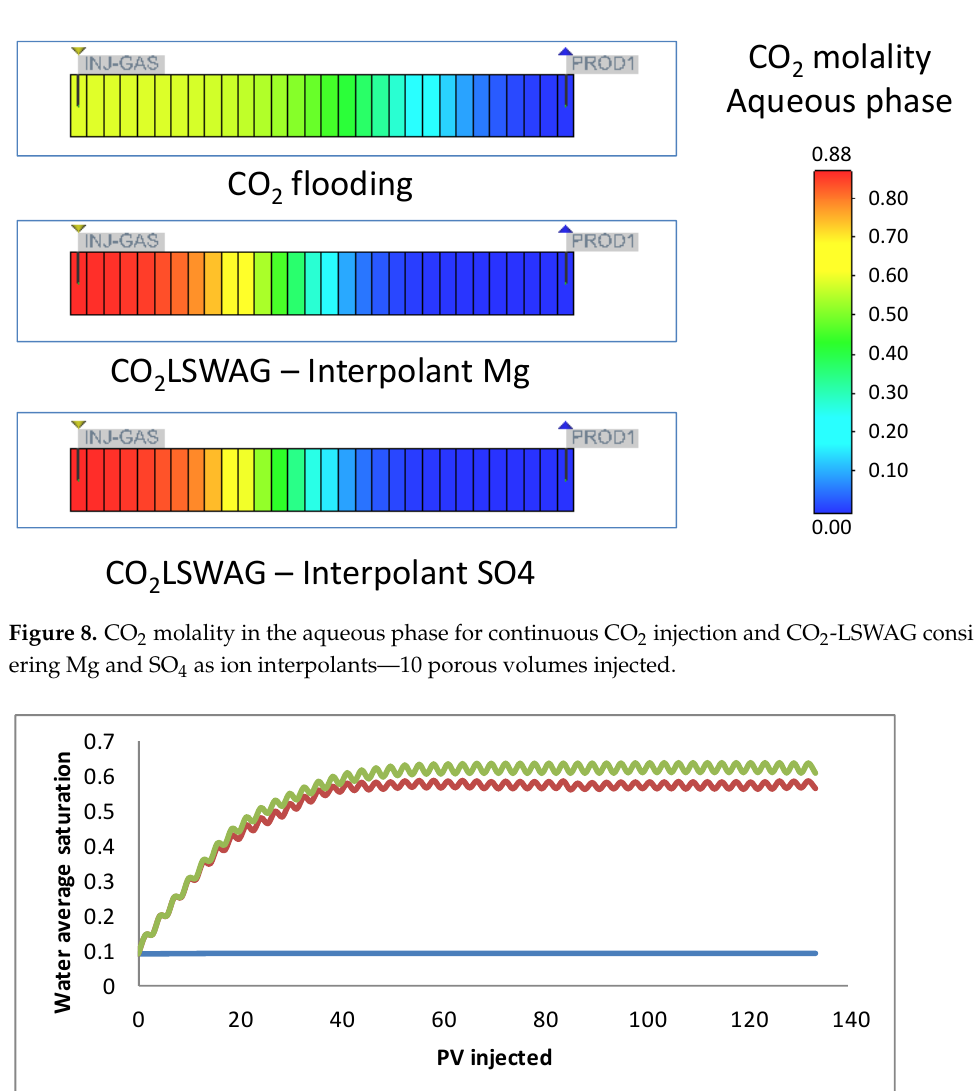
Figure 7. Mineral dissolution for continuous CO 2 injection and CO 2 -LSWAG considering Mg and SO 4 as ion interpolants.